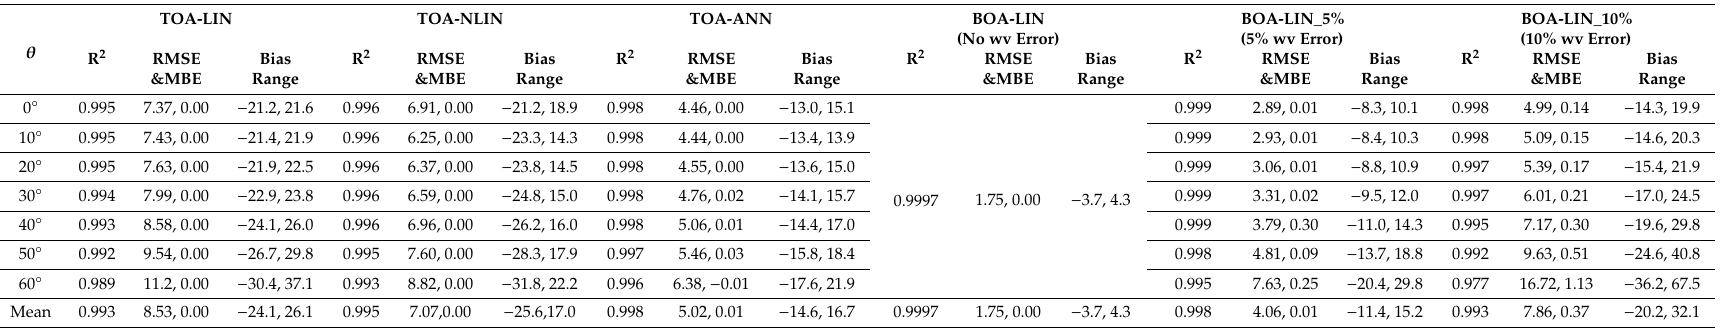
Table 7. Comparison results for four hybrid methods based on simulation dataset (W / m 2